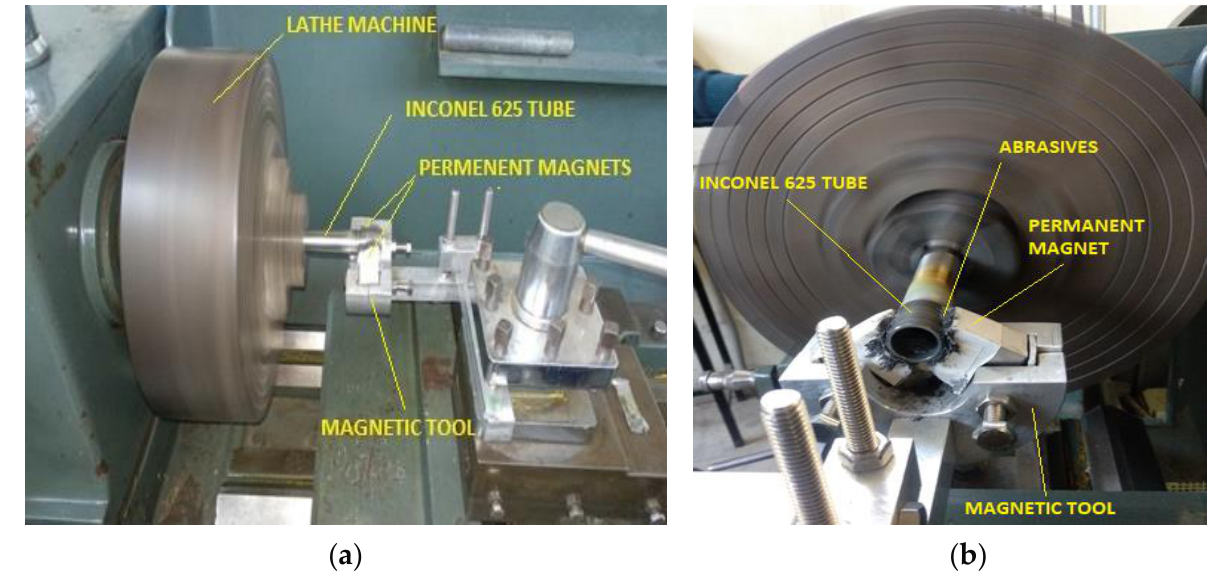
Figure 2. Experimental setup. ( a ) Side view; ( b ) front view.